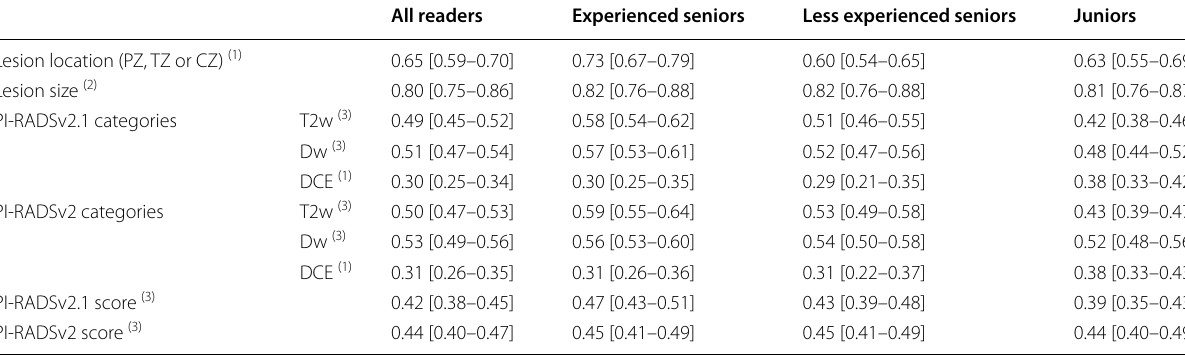
(1) Data are presented as mean kappa coefficient [95% confidence interval] (2) Data are presented as mean concordance correlation coefficients [95% confidence interval] (3) Data are presented as mean weighted kappa coefficients [95% confidence interval] PZ Peripheral zone, TZ Transition zone, CZ Central zone, T2w T2-weighted, Dw Diffusion-weighted, PI-RAD S Prostate imaging-reporting and data